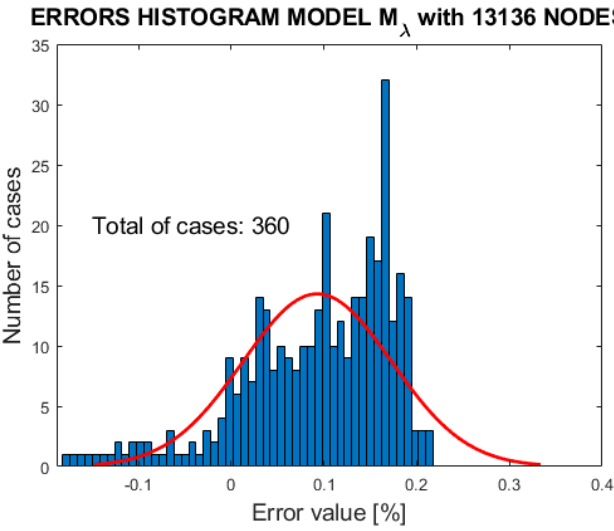
Figure 9. Errors distribution between CM and finite element method (FEM) using (cid:4670)𝑀 (cid:3090) (cid:4671) . The errors, as expected, decreased with the increase in mesh density, as shown in Table 3. Table 3. Temperature at a point of the tube with two conductivities using (cid:4670)𝑀 (cid:3090) (cid:4671) .